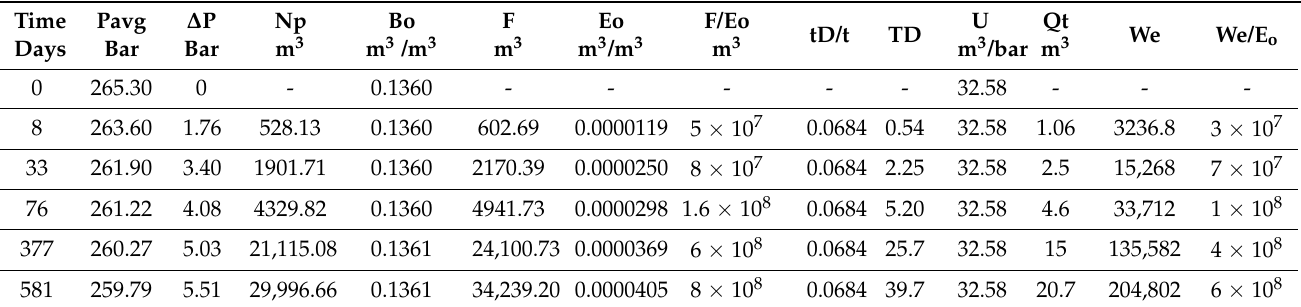
Table 6. Reserve estimations with water influx calculations using the Havlena–Odeh technique [13] (Shueib